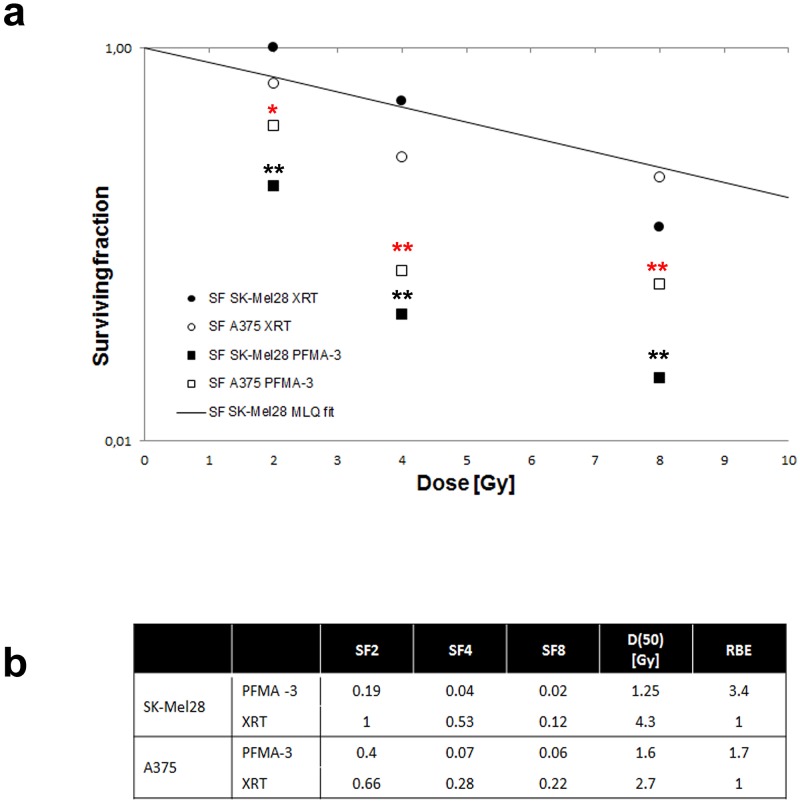
PFMA-3 causes radiation-induced clonogenic cell death greater than XRT.(a) Colony forming unit assay on SK-Mel28 and A375 cells irradiated with PFMA-3 and XRT at 2, 4 and 8 Gy. Data are representative of three independent experiments performed in triplicate and SD is not shown being less than 10%. Black (SK-Mel28) and red (A375) asterisks indicate statistically significant differences (*P<0.05, **P <0.005). (b) Radiobiological parameters of SK-Mel28 and A375 cell lines for PFMA-3 and XRT 2, 4, 8 Gy irradiation. SF2, SF4 and SF8 survival fraction at 2, 4 and 8 Gy respectively. D50, 50% survival dose. The D50 values for XRT device were used as standard reference for the RBE evaluations. The MLQ curve has been built from parameters suggested for SK-Mel28 and for low energy X-ray sources with a correction for the exposure time [37].